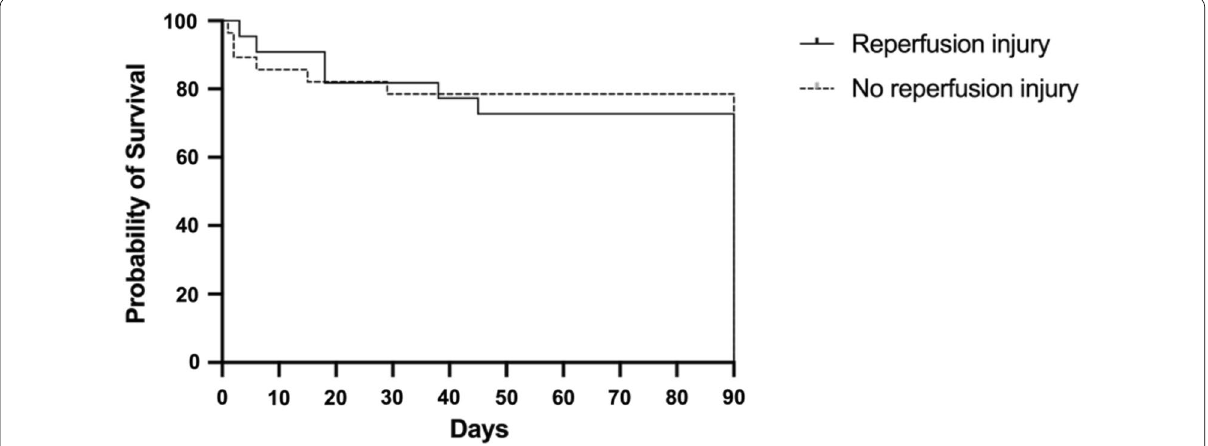
Fig. 5 Kaplan–Meier curve for the three-month survival rate according to the occurrence of a reperfusion injury (log rank: p